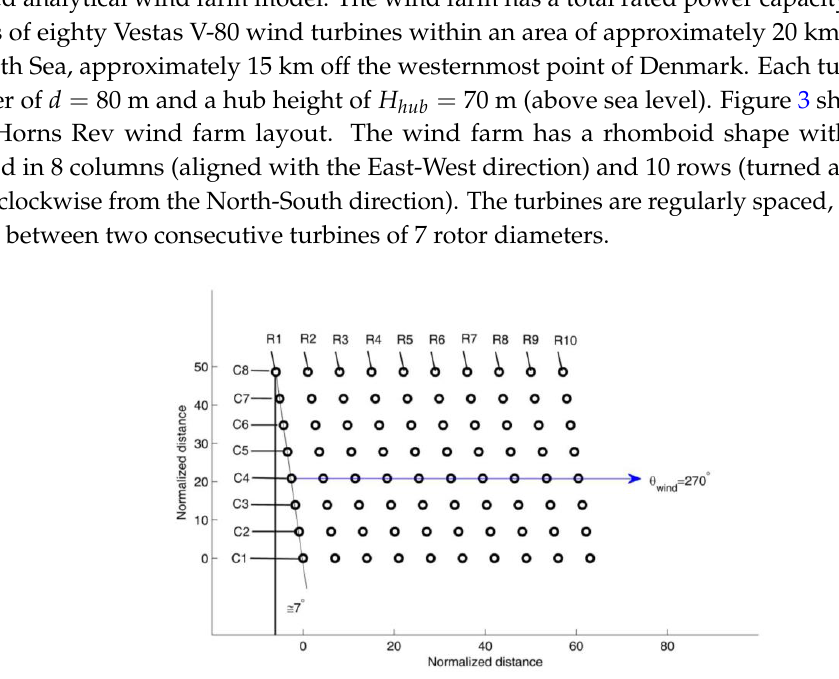
Figure 3. Layout of the Horns Rev wind farm. Distances are normalized by the rotor diameter 𝑑 = 80 .